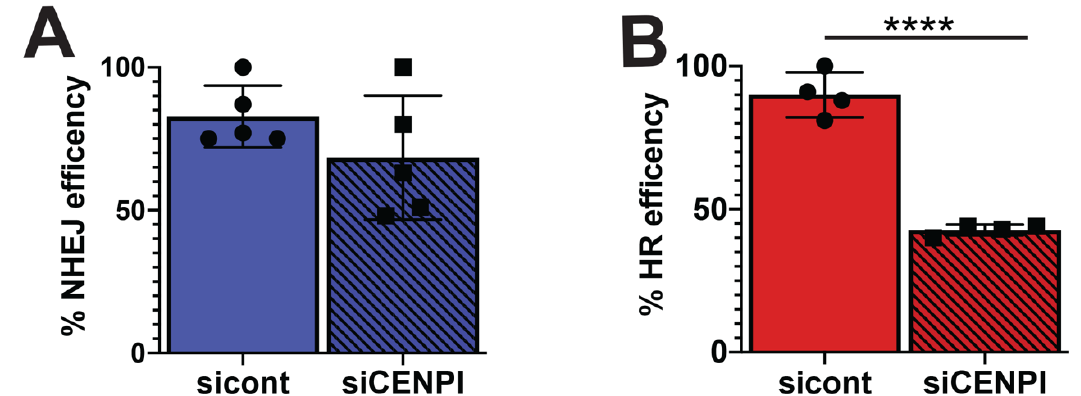
Figure 5. Loss of CENP-I impairs HR repair efficiency. ( A ) Non-homologous end-joining (NHEJ) or ( B ) homologous recombination (HR) repair efficiency was measured in the EJ5 and DR U2OS reporter cell lines exposed to control (cont) or CENP-I siRNA. For each experiment, NHEJ and HR repair efficiency was determined by counting 10,000 cells per condition and normalizing to sicont-treated cells. Statistical analysis was performed using Student’s t -test. **** = p ≤ 0.0001.